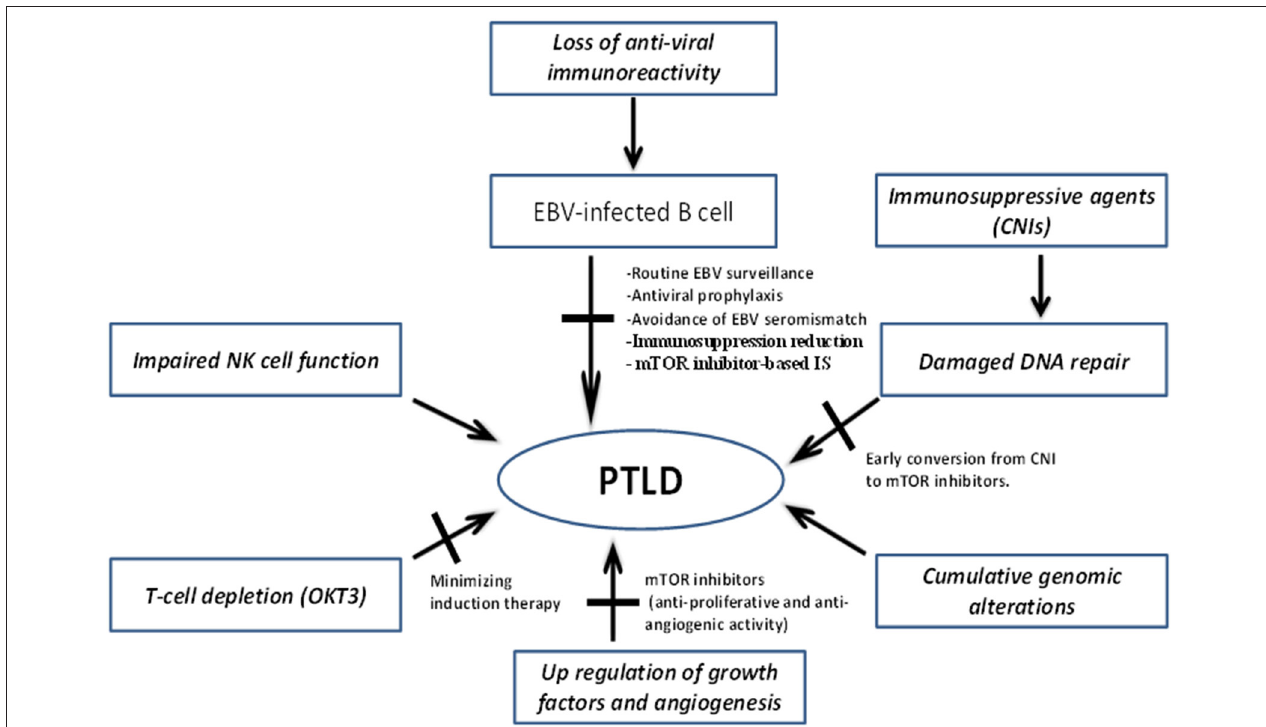
FIGURE 1 | Mechanisms underlying pathogenesis of PTLD and potential targets to mitigate disease development and progression. CNIs, Calcineurin inhibitors; EBV, Epstein–Barr virus; IS, immunosuppression; mTOR, mammalian target of rapamycin; NK, natural killer; PTLD, post-transplant lymphoproliferative disorder.